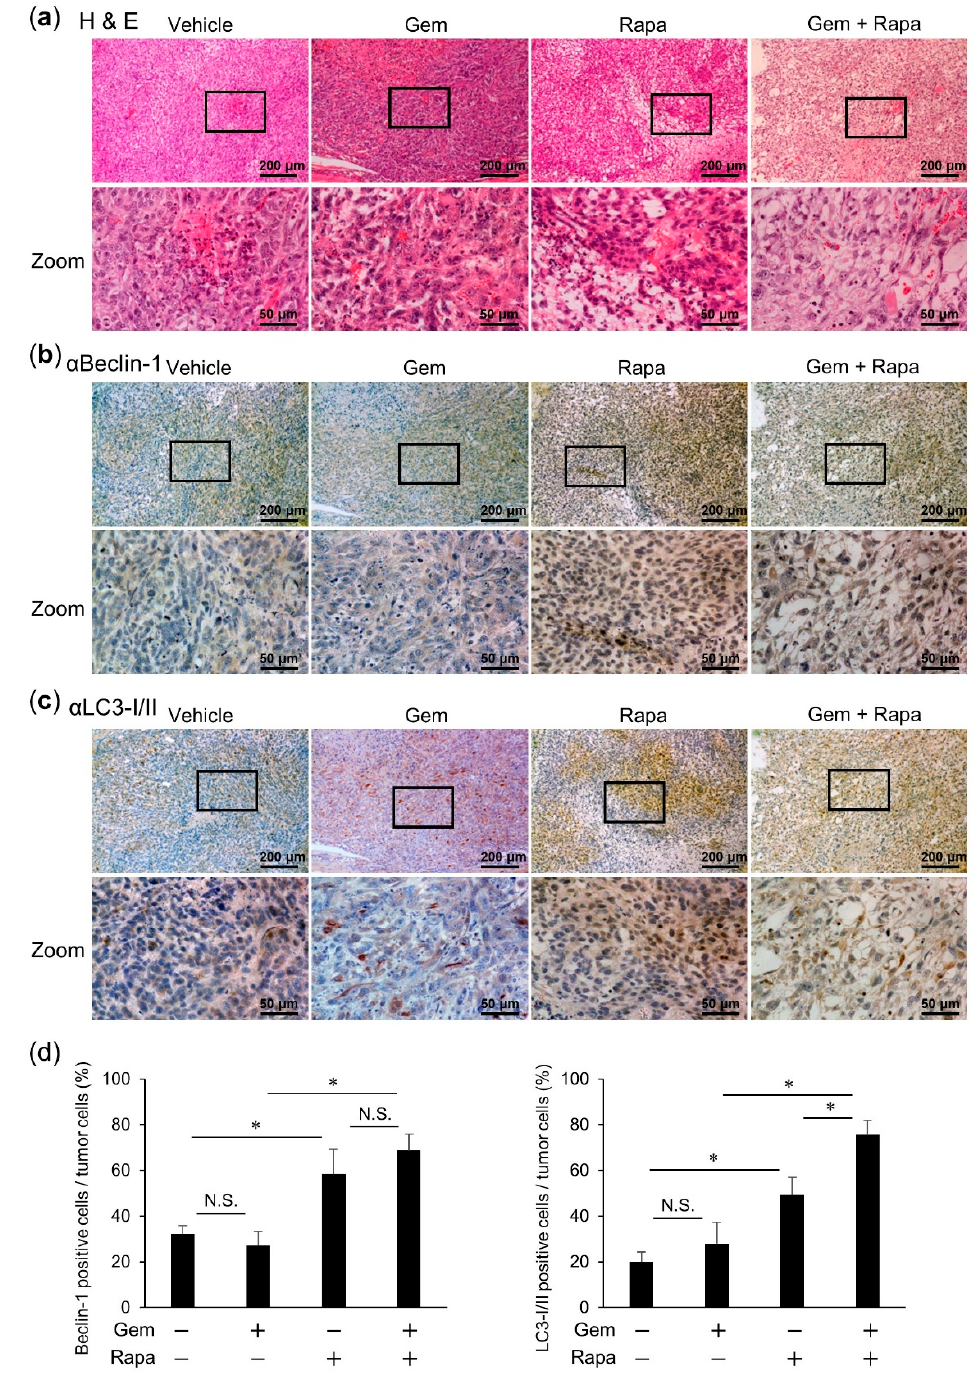
Figure 7. Combined administration of Gem and Rapa induced the autophagic flux in vivo. ( a – d ) Primary tumors were resected at day 28 after transplantation of LM8 cells. Hematoxylin-eosin (H & E) staining and immunohistochemical (IHC) staining were performed using primary antibodies against Beclin-1 and LC3-I/II, followed by quantification. Bar = 200 μ m in the upper panels. Bar = 50 μ m in the lower panels. Data are shown as the mean ± SD ( n = 5). * p < 0.05. N.S., not significant.